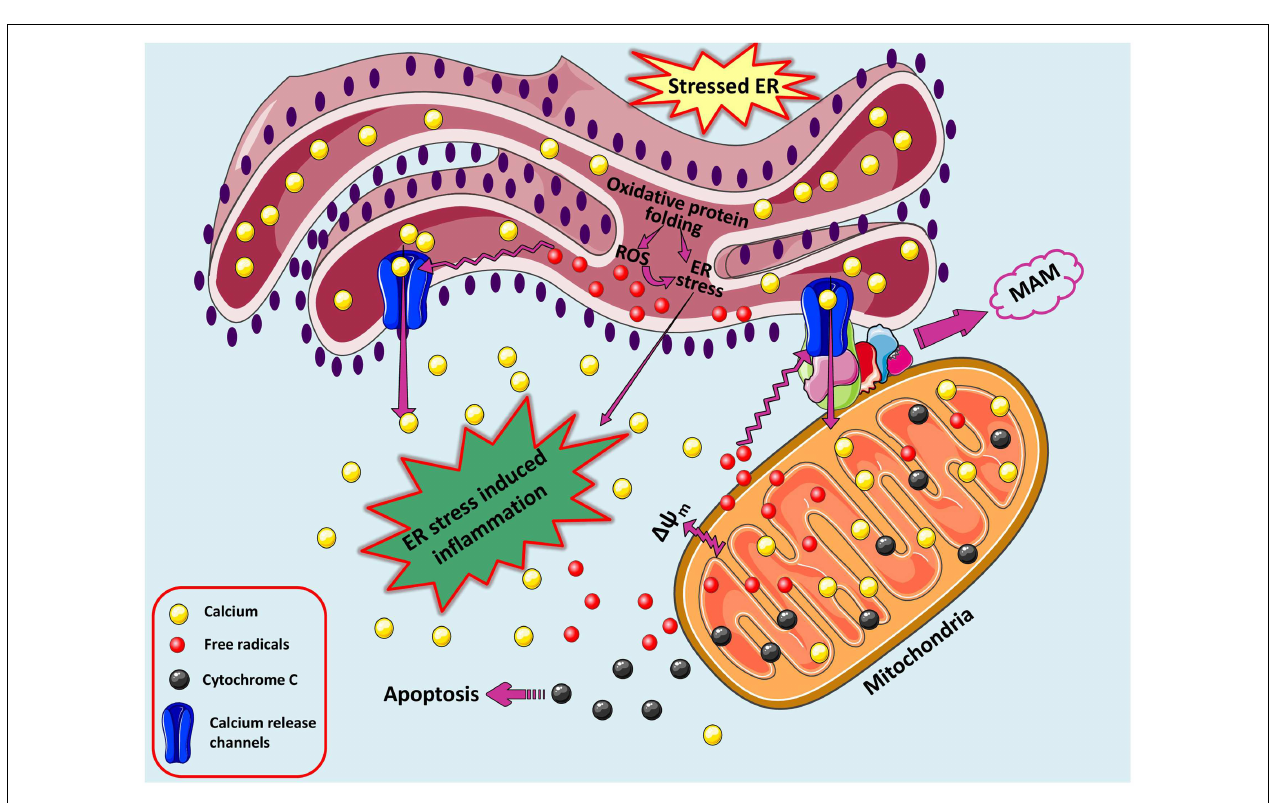
cytosolic calcium and calcium entry in mitochondria from ER via MAM-associated channels can stimulate mitochondria metabolism to produce more ROS. Increased mitochondrial calcium concentration causes cytochrome c release, altered membrane potential that eventually triggers cellular death programs.The increased protein folding demand, calcium and ROS signaling integrates with UPR pathways and can potentially lead to inflammatory